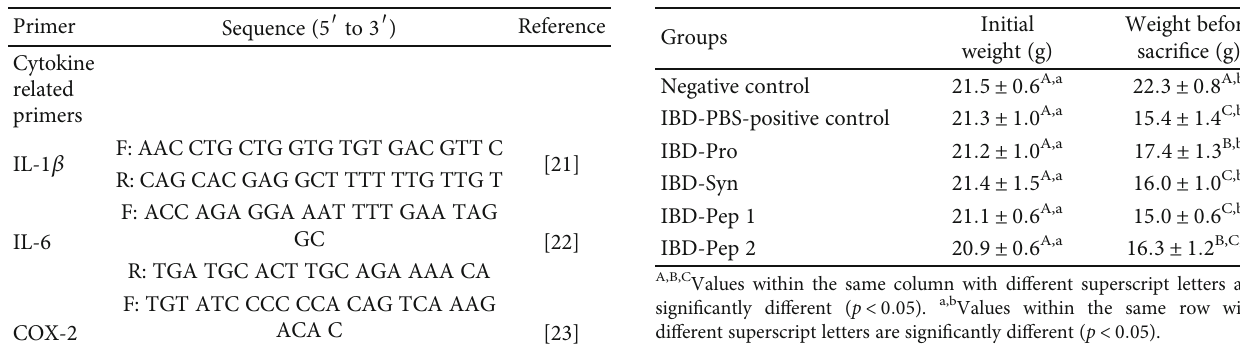
Table 3: Primers for quantitative real-time reverse transcription polymerase chain reaction.